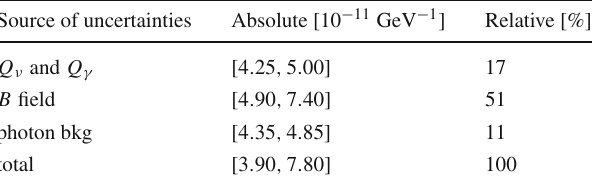
Table 2 Uncertainties on the ALP-photon coupling g a γ constraint, varying the condition of the benchmark case. The last row indicates the total uncertainty range when all sources are combined to form a most optimistic and most pessimistic scenario